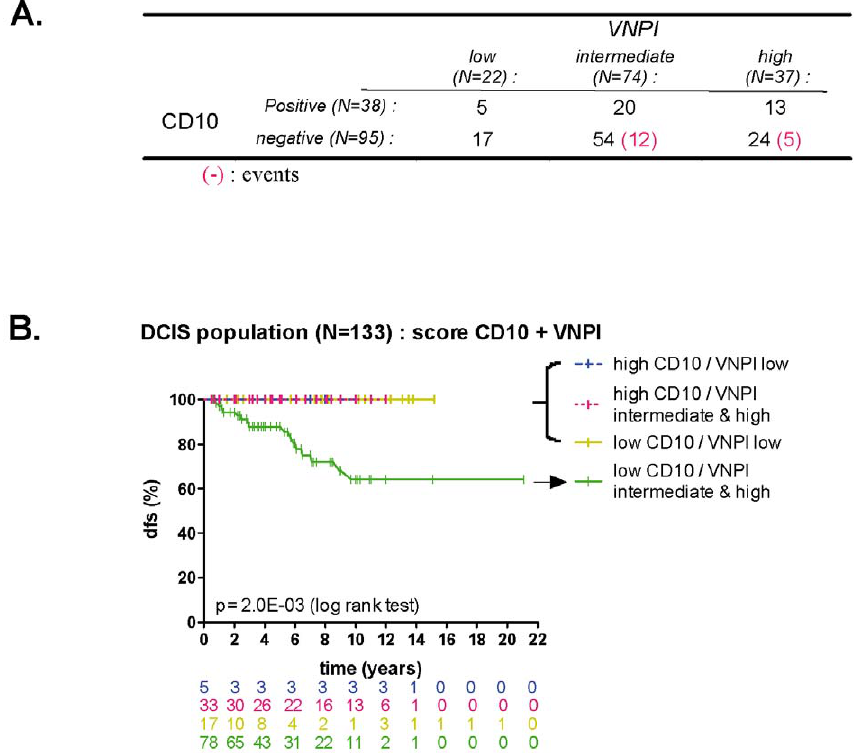
Figure 4. Combined CD10 and VPNI risk. (A) Cross-tabulation between CD10 qRT-PCR expression and VNPI score. (B) Disease-free survival analysis for patients with DCIS according to CD10 mRNA expression by qRT-PCR combined with VNPI risk group.